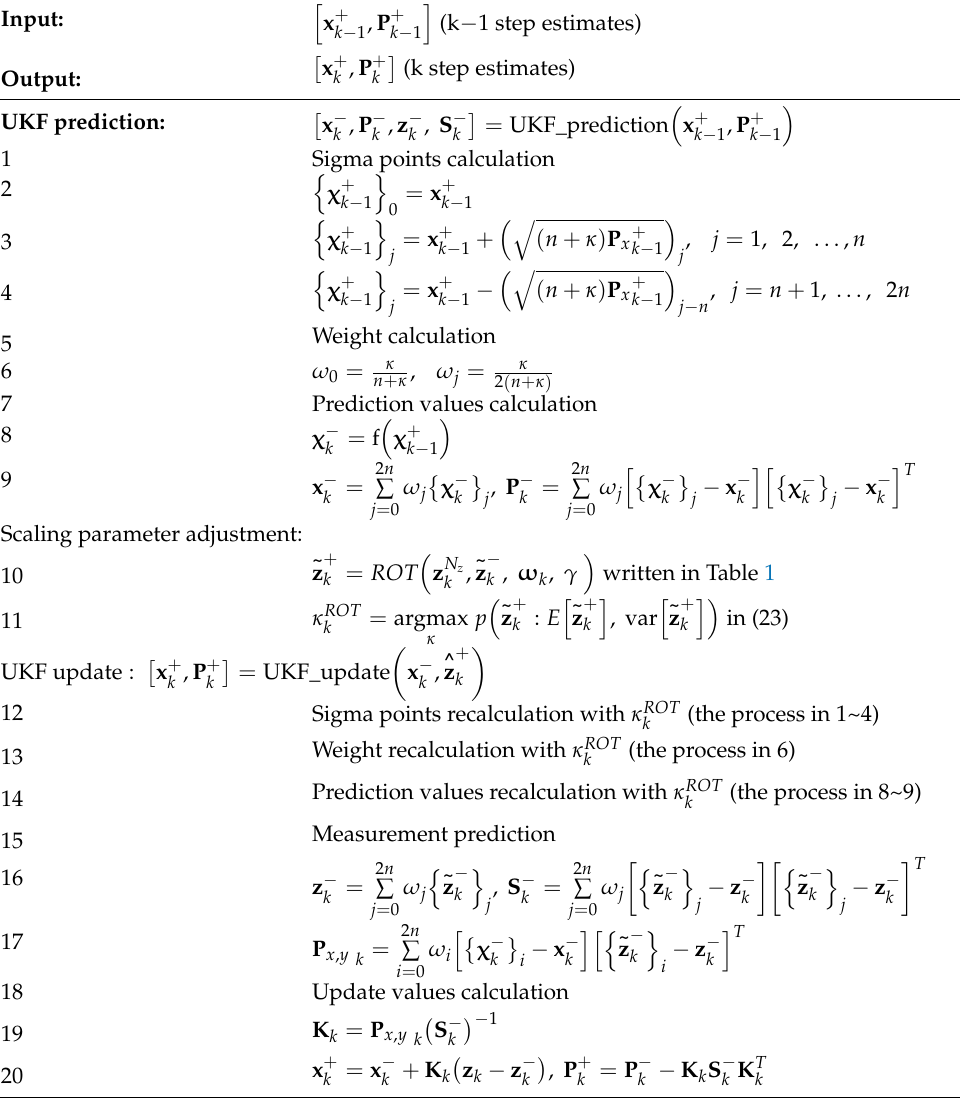
Table 2. Pseudocode of the proposed